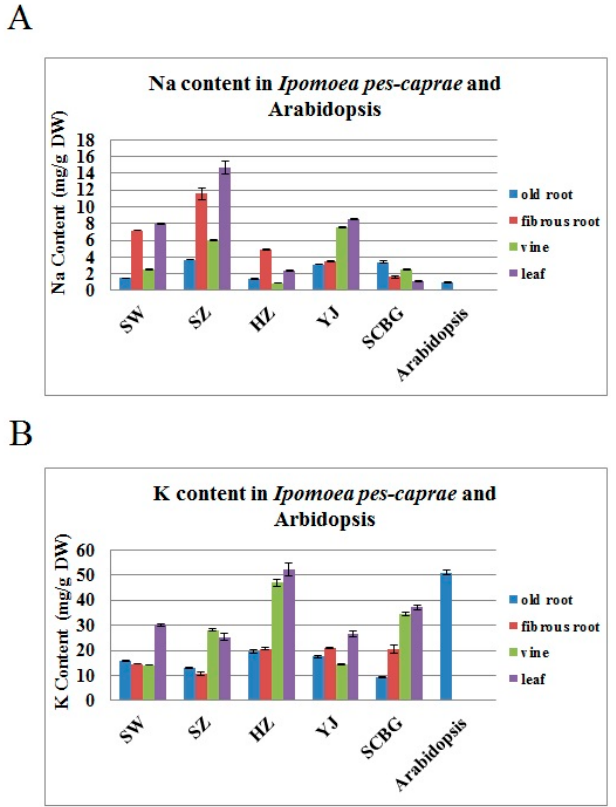
Figure 1. Na + ( A ) and K + ( B ) contents in I. pes-caprae collected from five different areas in Guangdong province. SW: sample from Shanwei (22°47 ′ 10.97 ″ N, 115°10 ′ 22.83 ″ E); SZ: sample from Shenzhen (22°32 ′ 13.16 ″ N, 114°29 ′ 11.26 ″ E); HZ: sample from Huizhou (22°41 ′ 24.81 ″ N, 114°44 ′ 48.02 ″ E); YJ: sample from Yangjiang (21°34 ′ 37.34 ″ N, 111°52 ′ 15.95 ″ E); SCBG: sample from South China Botanical Garden (23°18 ′ 49.89 ″ N, 113°35 ′ 84.32 ″ E). An Arabidopsis sample is also shown as a glycophyte control. All